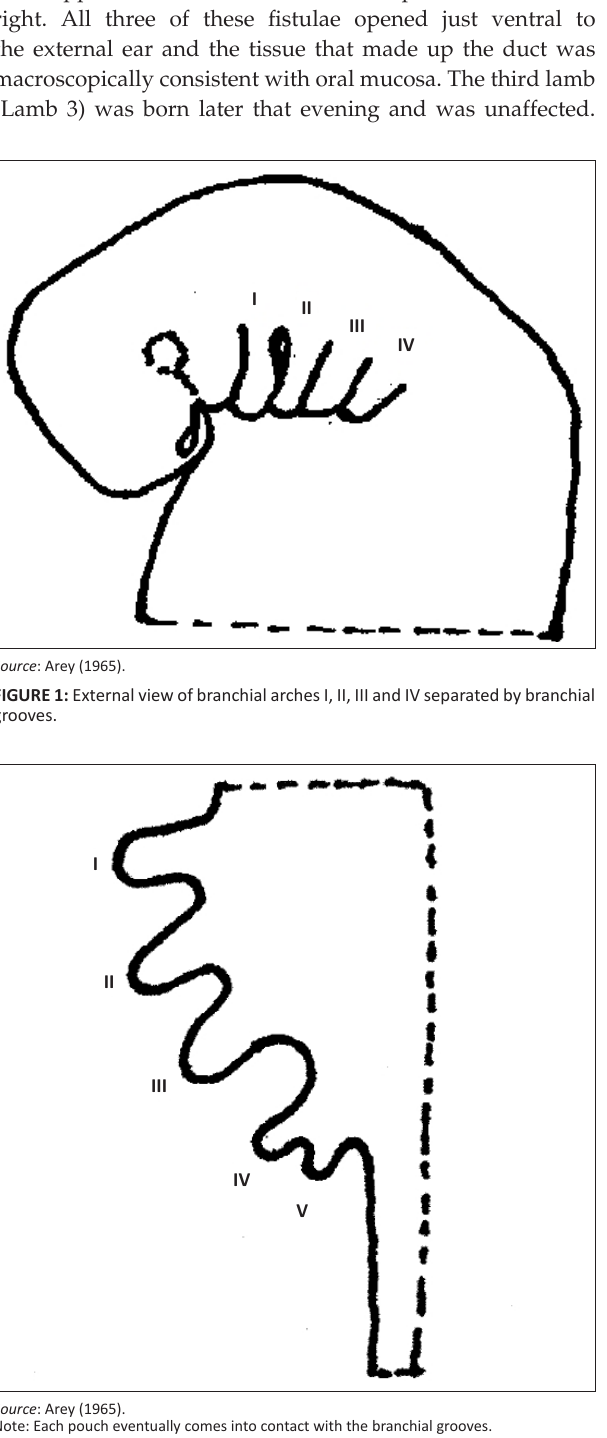
FIGURE 5: (1) Lamb 2 showing oro-auricular Figure 5